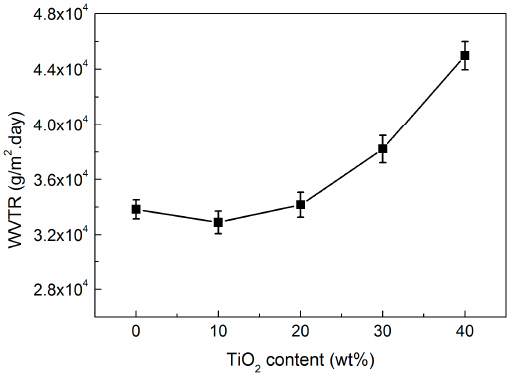
Figure 6. Water vapor transmission rate (WVTR) of the PP/TiO 2 composite membranes as a function of TiO 2 content.